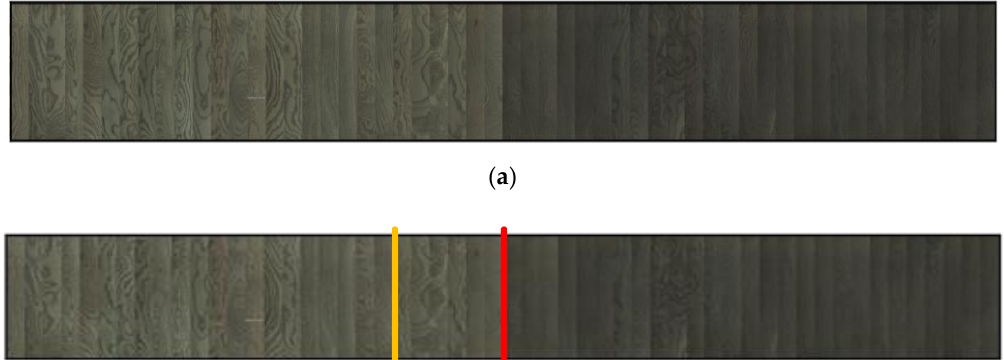
Figure 6. Processing method for uneven sample numbers. ( a ) Color sequence of solid wood floors with uneven sample size. ( b ) Delineating demarcation point to realize the depth assignment of uneven solid wood floors.